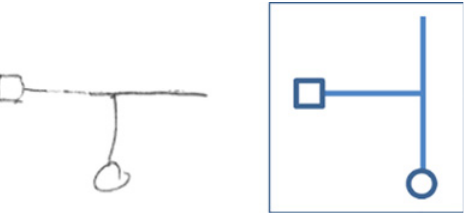
Fig 10. Example of a "false-corridor" drawing. On the left is a drawing made by a young participant, who completed maze D in the auditory, stationary condition. A circle denotes the starting point, and a square denotes the end point. On the right is a sketch of the actual maze. This example demonstrates what we termed a "false corridor", where a dead-end corridor was drawn at 90° to its actual